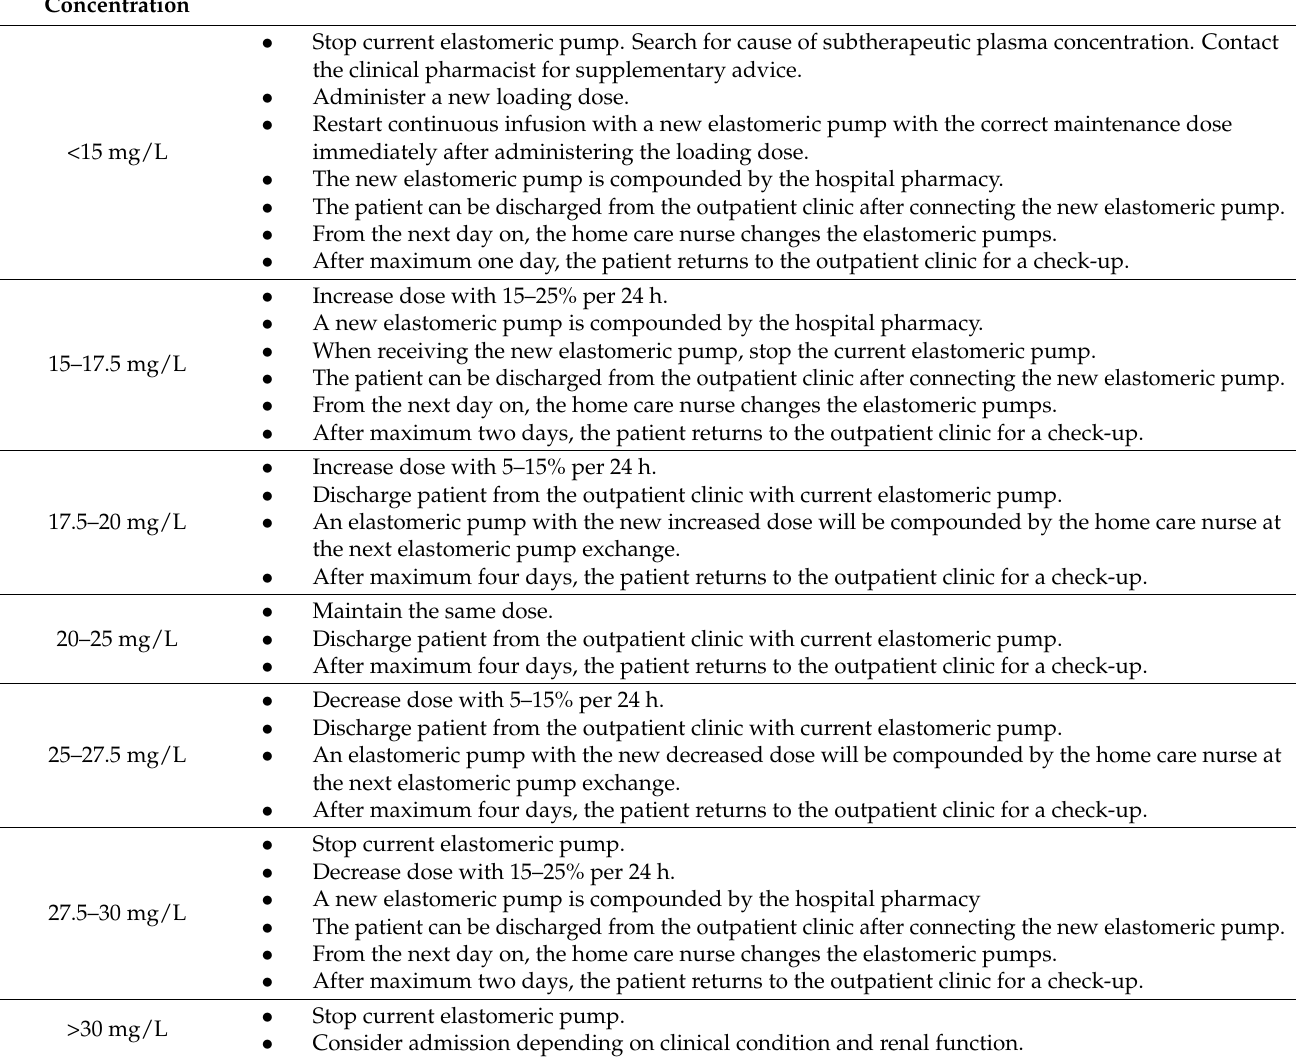
Table 2. Dose adjustment protocol for interpretation of vancomycin plasma concentrations during